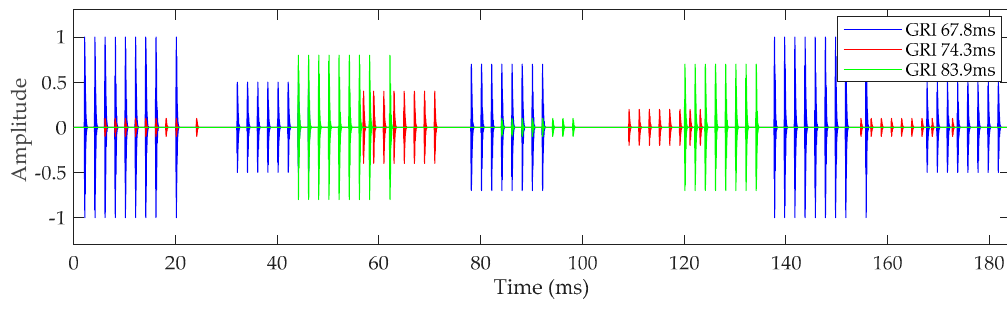
Figure 4. Schematic diagram of cross-rate interference (CRI).